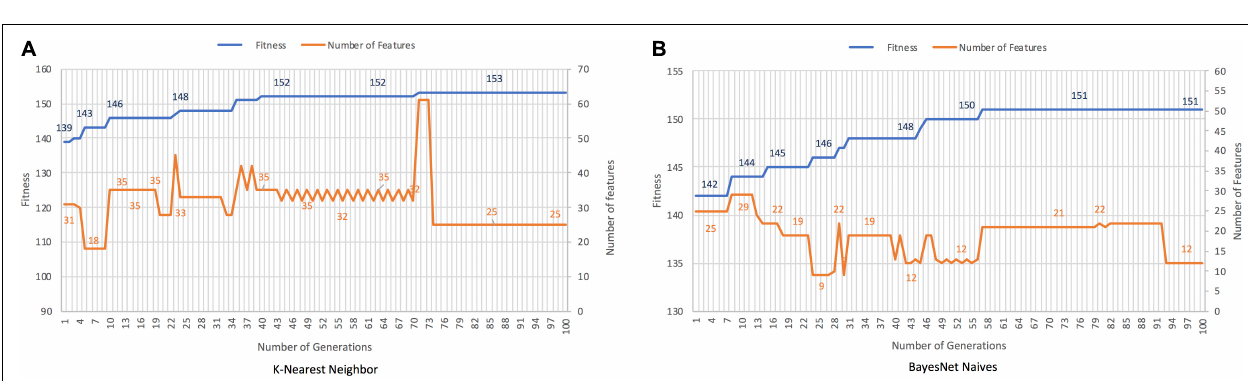
FIGURE 5 | Results for bvFTD vs. AD, with K-Nearest Neighbor (A) and BayesNet Naives (B) as the fitness function. The X axis represents the generation, the main Y axis corresponds to the fitness value, and the secondary Y axis shows the features selected. The blue line represents the progression of fitness and the orange line the smallest set of features in the current